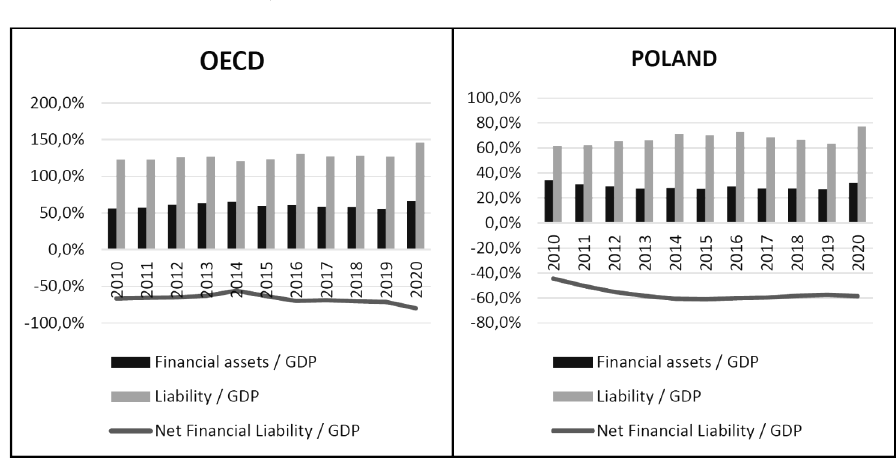
Financial assets, liabilities and balance of financial